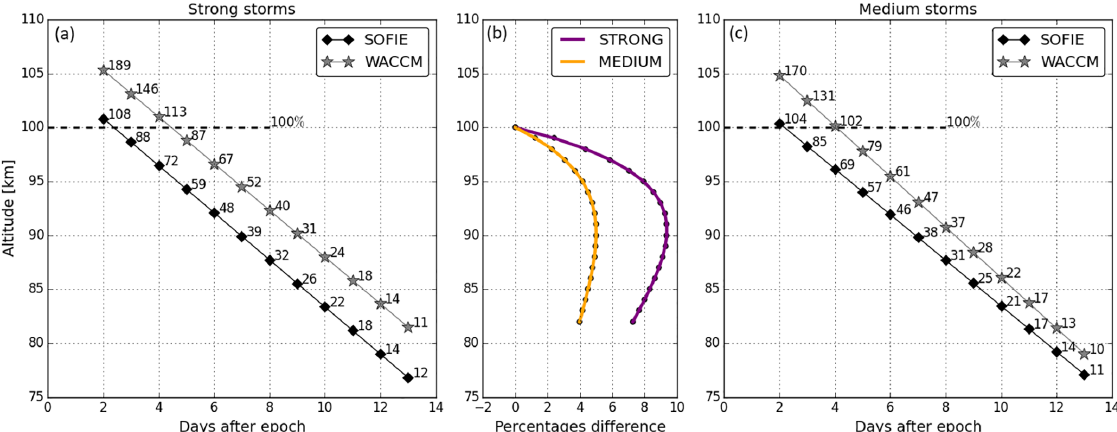
Figure 12. Percentage of NO for each day after the epoch that remains as calculated from the NO concentration at 100km altitude for days with (a) strong and (c) medium geomagnetic activity. (b) Difference of NO percentages between SOFIE and WACCM for each